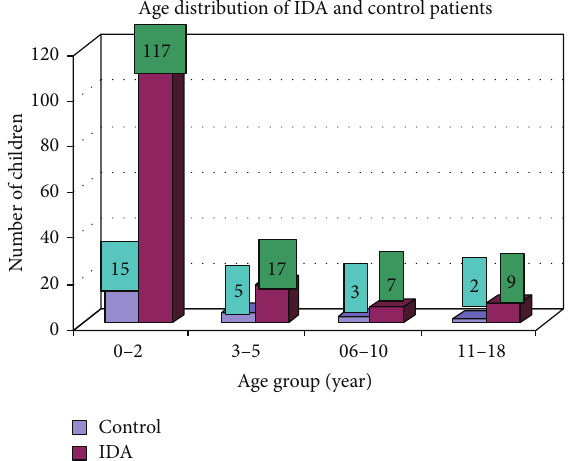
Figure 1: Showing age distribution of control and iron deficiency anaemia.